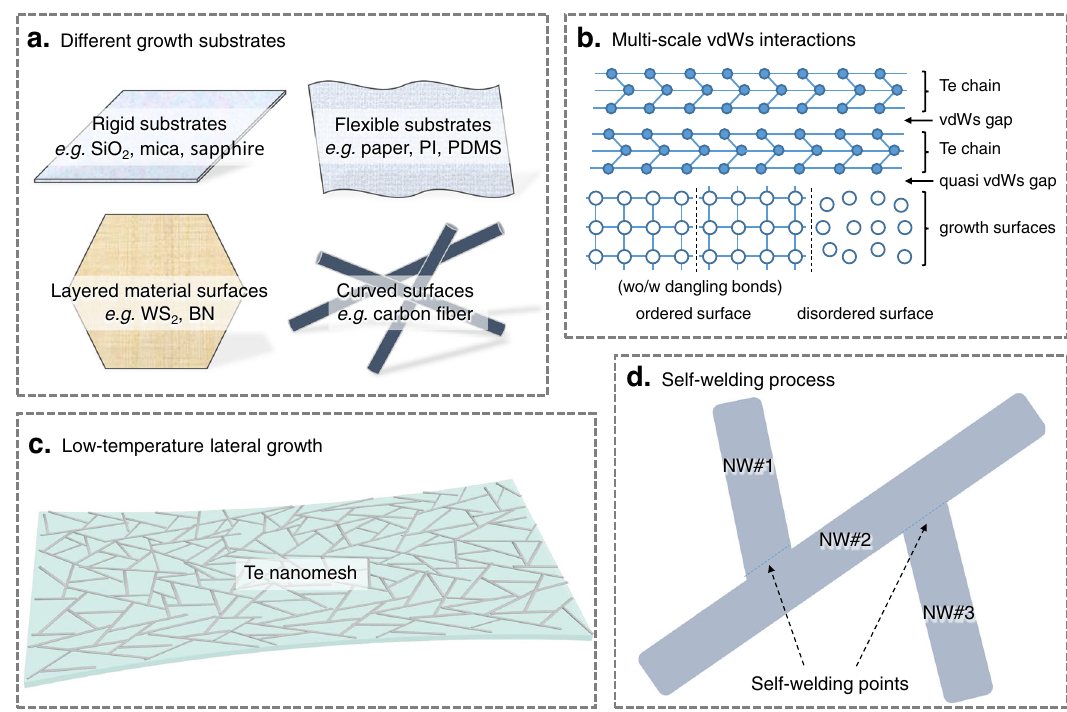
Fig.1|Schematicillustrationsofthelow-temperatureTenanomeshgrowthon arbitrary surfaces. a Growth substrates used in this work with different forms, shapes, and sizes. b Multi-scale van der Waals (vdWs) interactions of